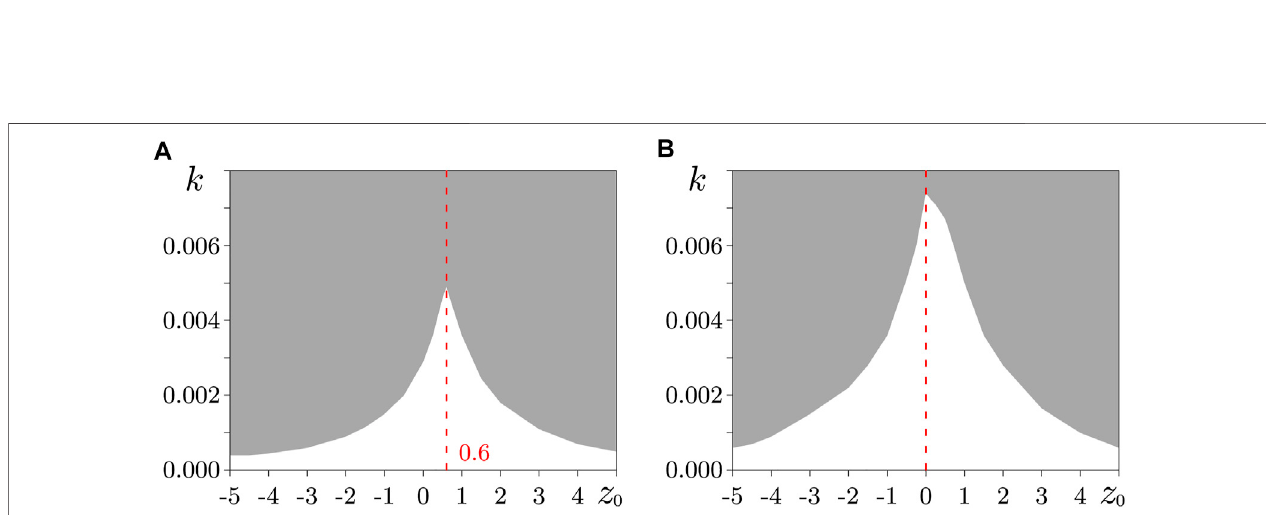
FIGURE 3 | The area of complete synchronization of traveling waves (gray area) in identical rings in the case of ideal memristive coupling δ = 0 (A) and in case of coupling through memristors with the forgetting parameter δ = 0.1 (B) . The dashed vertical line marks the z 0 max value corresponding to the maximum synchronization threshold. Complete synchronization was determined in accordance with the criterion (Eq. 5) , the time for calculating the synchronization error was 1,000 units of dimensionless time.